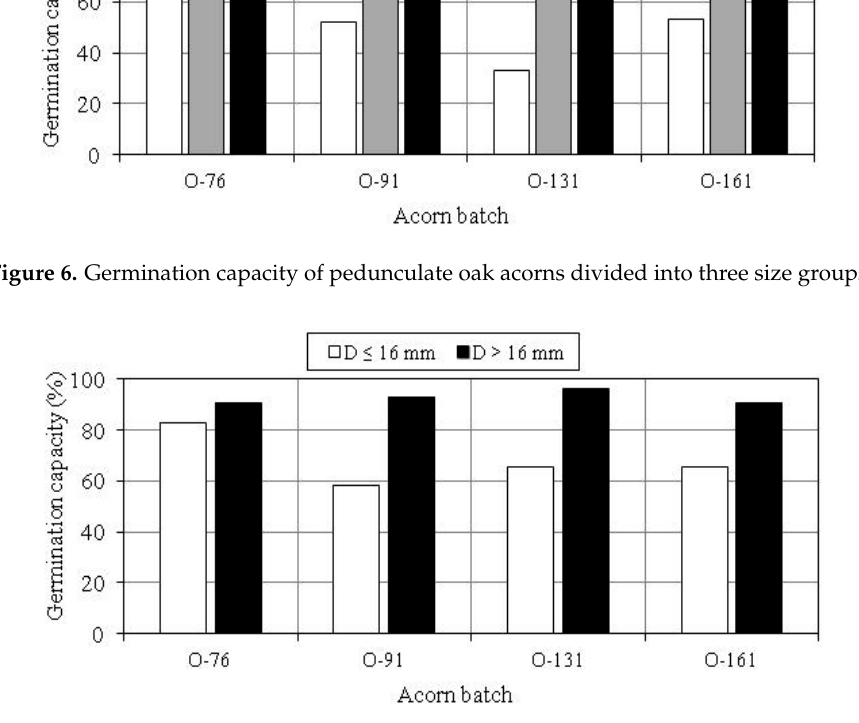
Figure 7. Germination capacity of pedunculate oak acorns divided into two size groups.